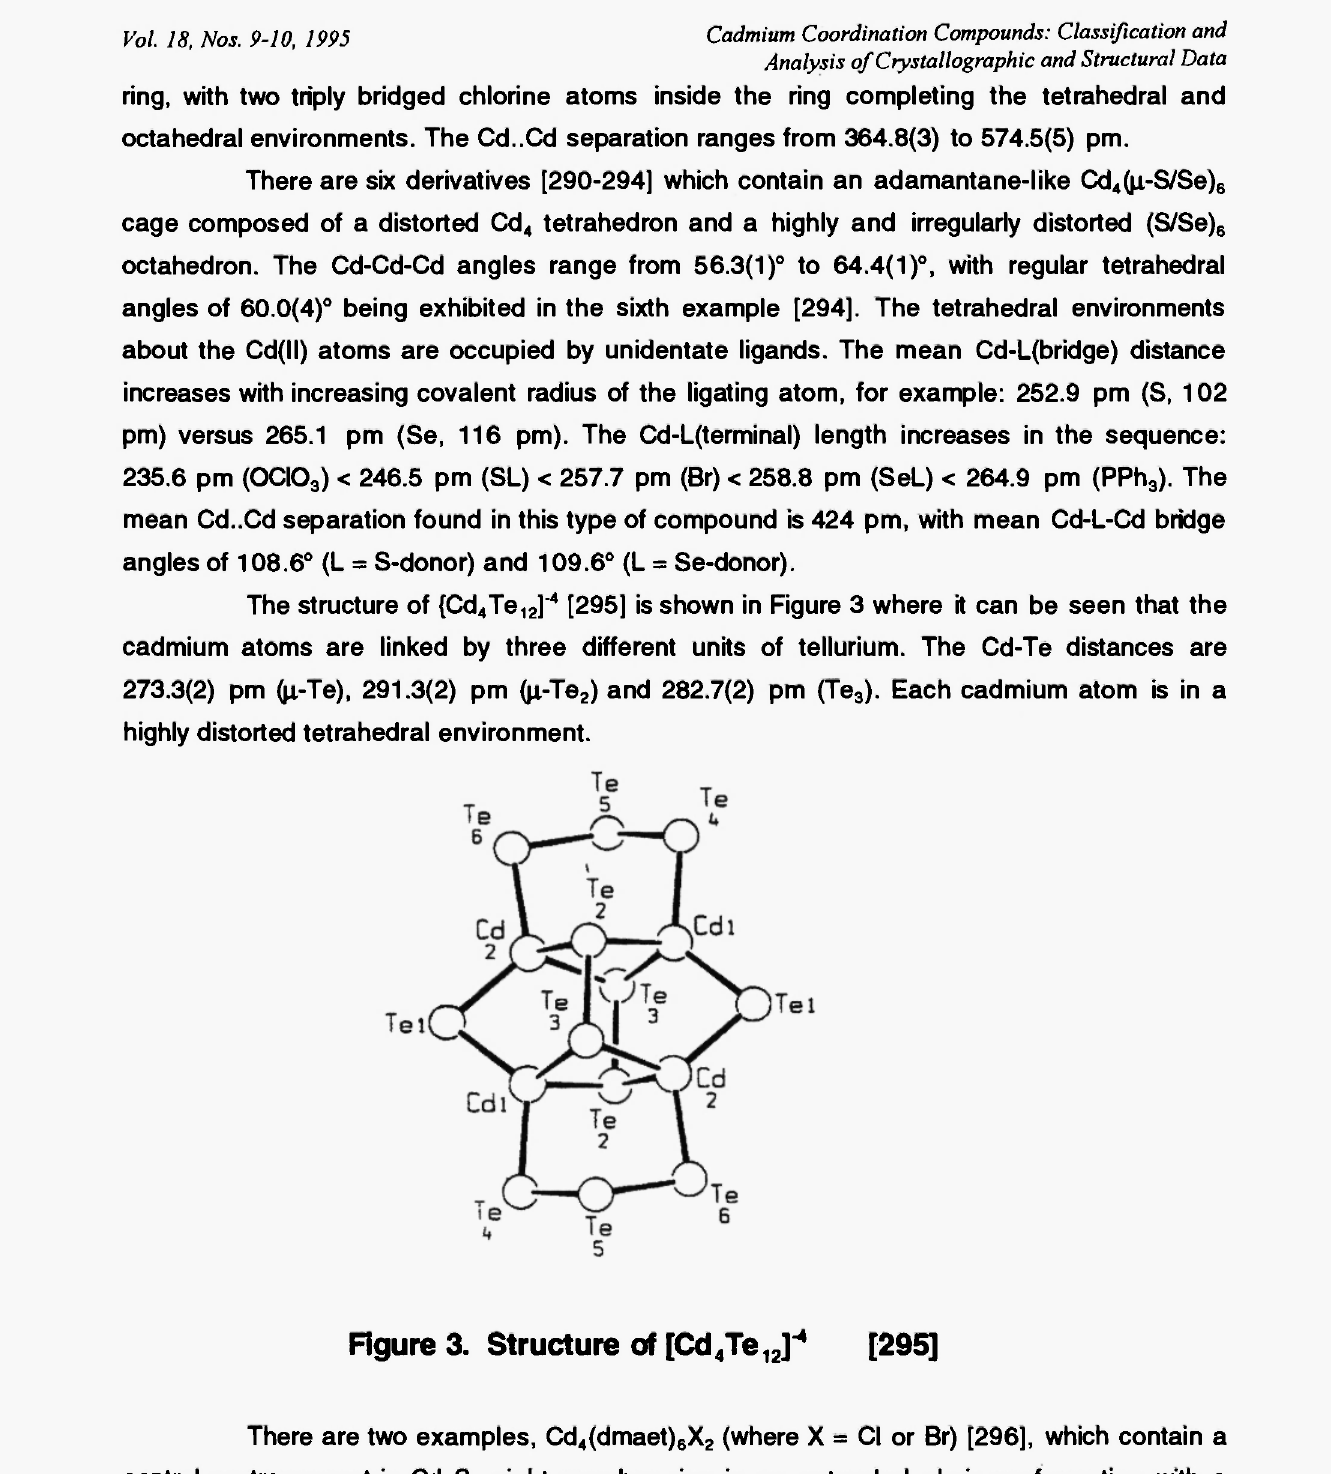
Figure 3. Structure of [Cd